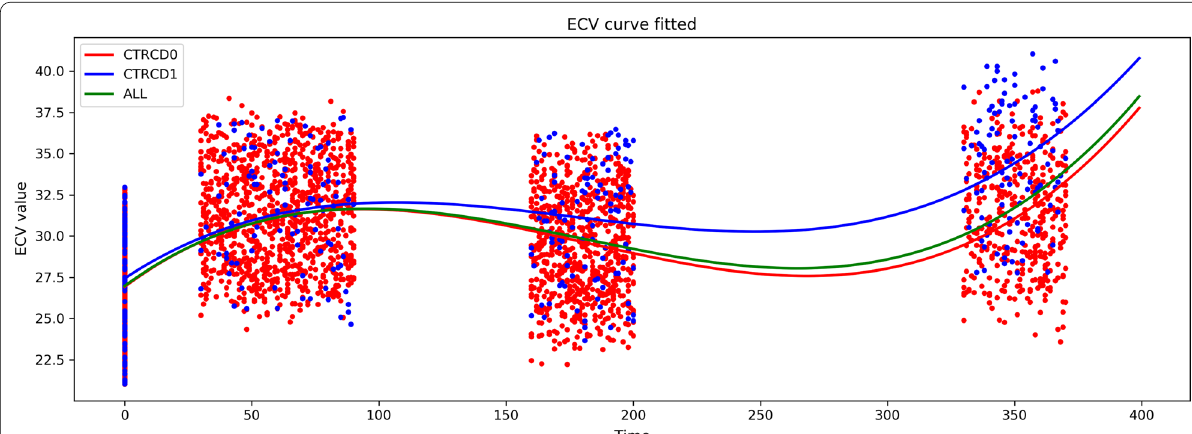
Fig. 3 The temporal changes and linear fitting of longitudinal changes of myocardial ECV of BC patients. CTRCD0 , patients without cancer therapy-related cardiac dysfunction; CTRCD1 , patients with cancer therapy-related cardiac dysfunction; ECV , myocardial extracellular volume; BC , breast